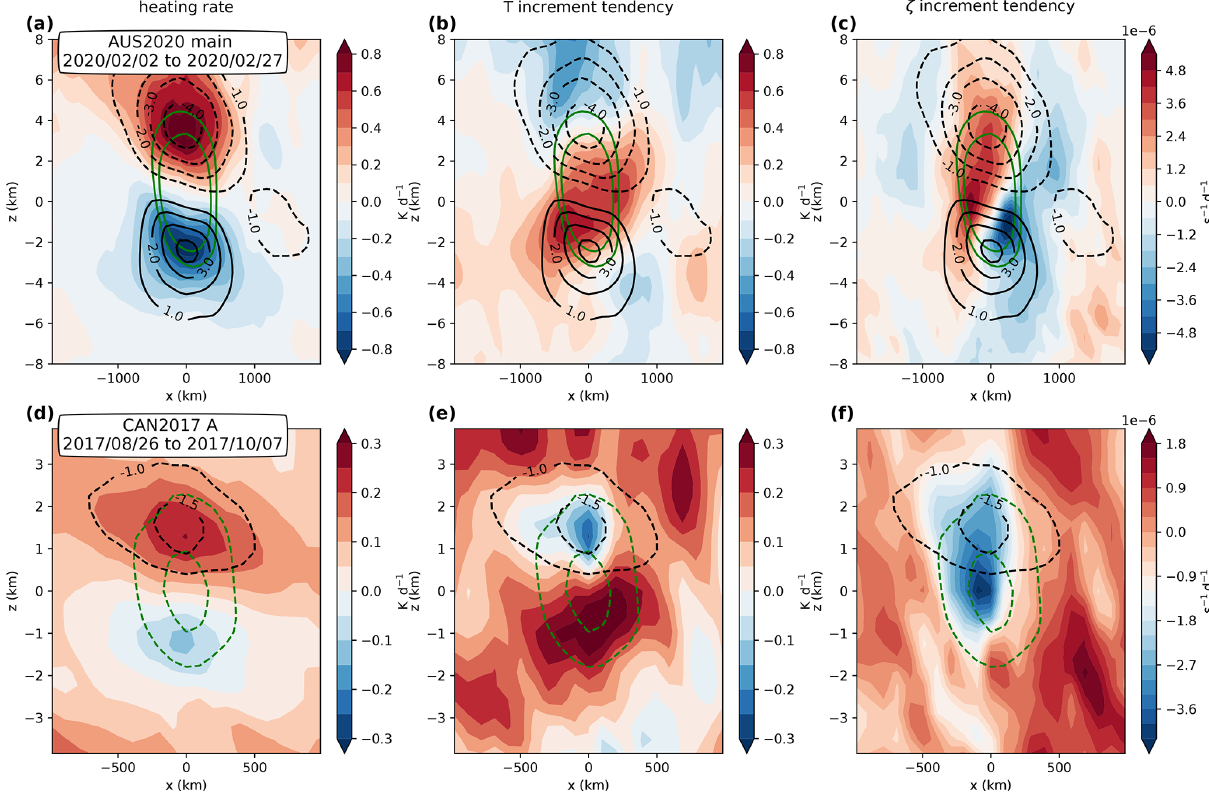
Figure 9. Time-averaged composite sections of the ERA5 total heating rate (a,c) , increment-induced temperature (b,e) and vorticity ten- dency (c,f) following two selected smoke-charged vortices, the major vortex from the 2020 Australian wildfires described in Khaykin et al. (2020) (a–c) and vortex A (d–f) . The green lines are contours of anticyclonic vertical vorticity (corresponding to 3 × 10 − 5 and 5 × 10 − 5 s − 1 for panels a–c , and − 1.5 × 10 − 5 and − 2.5 × 10 − 5 s − 1 for panels d–f ). The black contours are the temperature anomaly with respect to the zonal mean. Note that the displayed horizontal range is reduced by a factor of 2 for vortex